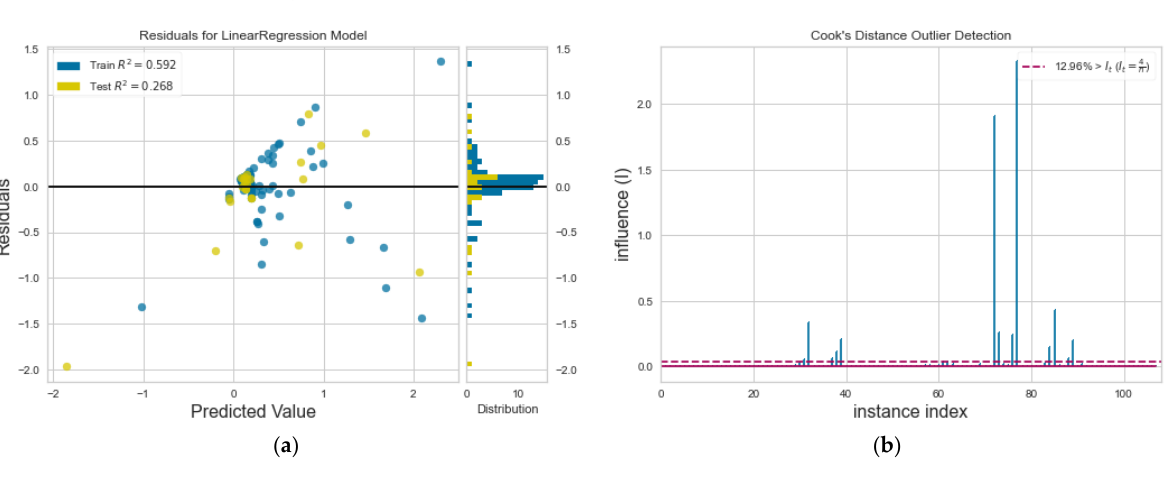
( d ) Figure 9. ( a ) Residuals plot and ( b ) Cook’s distance for u m , and, after the removal of outliers from the dataset, ( c ) new re- siduals plot and ( b ) new Cook’s distance. 4. Discussion The ML regression technique incorporated in this work has shown a good perfor- mance in predicting the three transport properties of fluids, D , η and k , and the average velocity across the channel, u m , a property that is a basic element in many computational fluid mechanics equations, such as the estimation of the Reynolds number [38]. To our knowledge, data from nanoscale simulations have been mainly used for coupling ab ini- tio calculations to MD simulations for the construction of Coarse-Grained systems or for decreasing the order of ordinary and partial differential equations. Nevertheless, as ML is currently a widely investigated field in the condensed matter physics region, it is ex- pected to continuously provide new research results. Data curation, when obtained from various databases, is an important issue as in- dicated by early papers in this domain [47], although it seems that there is no commonly accepted protocol or set of procedures for data preprocessing, with data regulariza- tion/normalization one of the widely used techniques. Our input data were normalized before being fed to the regression model. A small, though representative, dataset, was chosen which covers a wide range of simulation cases. The quality of the datasets is con- sidered high with respect to the impact of the journals from which they were imported. Checking for outliers and their effects in the resulting model can also act as a control for the quality of the dataset. As regards the number of points to incorporate in such a pro- cedure, there is no clear answer. In the literature, there are cases for successful ML mod-